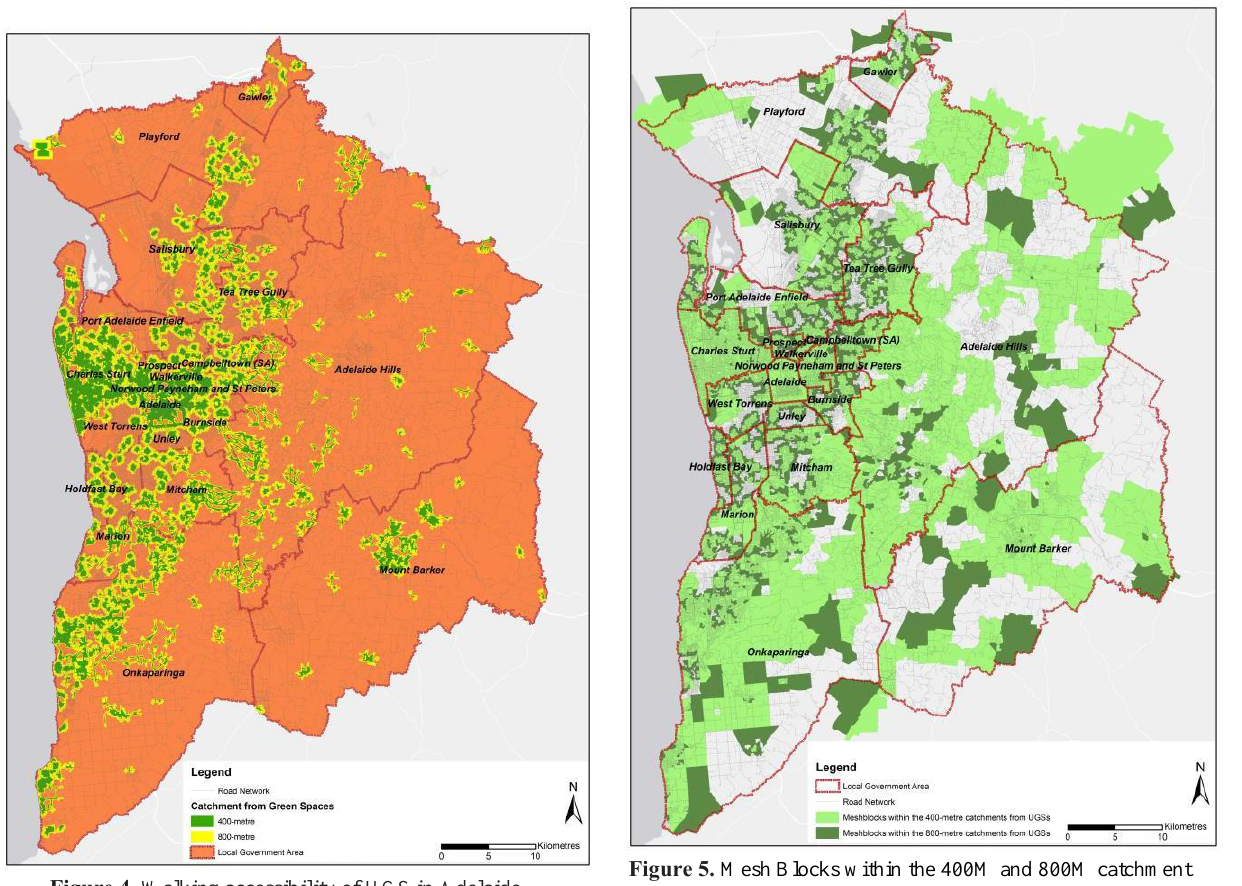
Figure 4. Walking accessibility of UGS in Adelaide Metropolitan Area